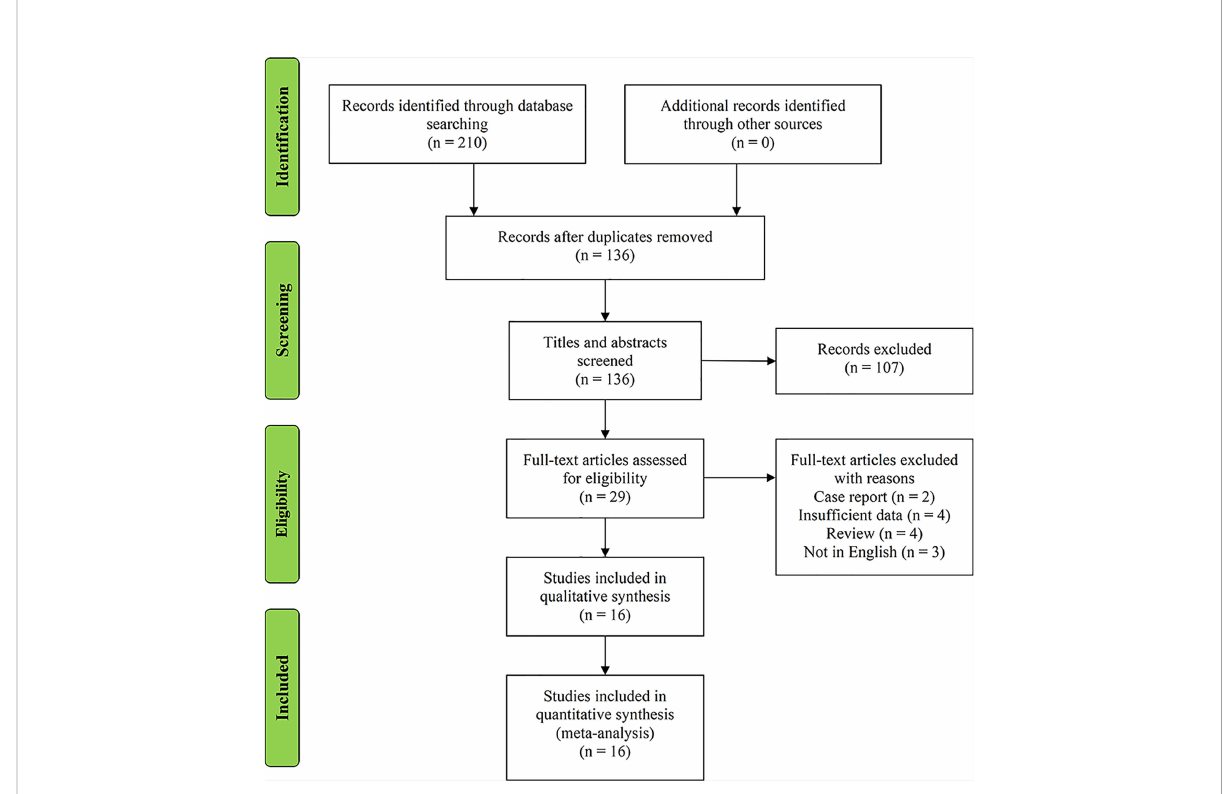
FIGURE 1 Flowchart of study